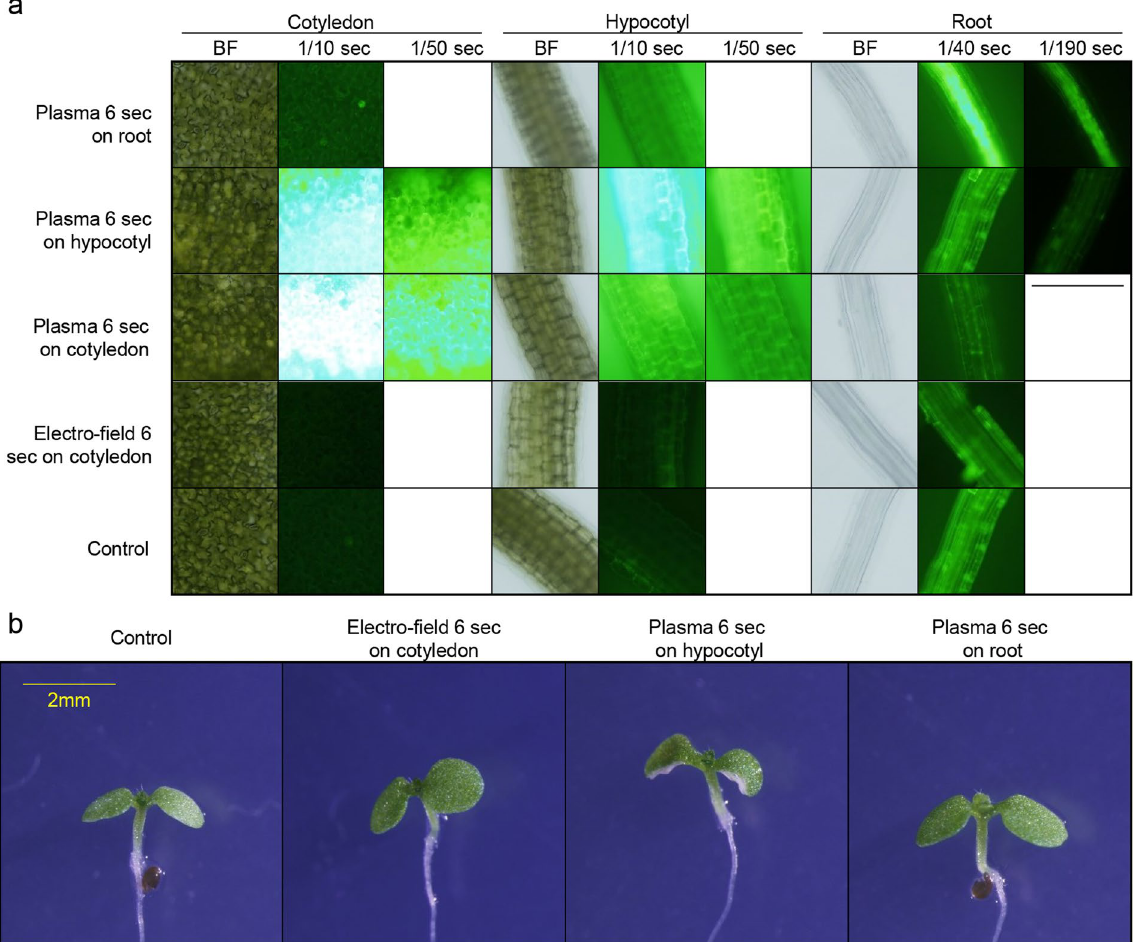
Figure 5. Photosynthetic organ treated plasma induces cell death. ( a ) Plasma treated in different organs for 6 seconds. BF indicates bright field. Time indication under indicated tissue is exposure time (seconds). Scale bar = 500 um. Representative image were determined from 5 experiments for each conditions. ( b ) Phenotype of seedlings treated with indicated conditions after 3 days of incubation in long day. Scale bar = 2 mm. Representative image were determined from 5 experiments for each